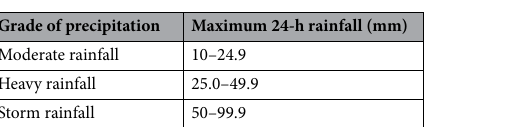
Figure 1. The location of Zhangjiachong watershed and runoff plots.